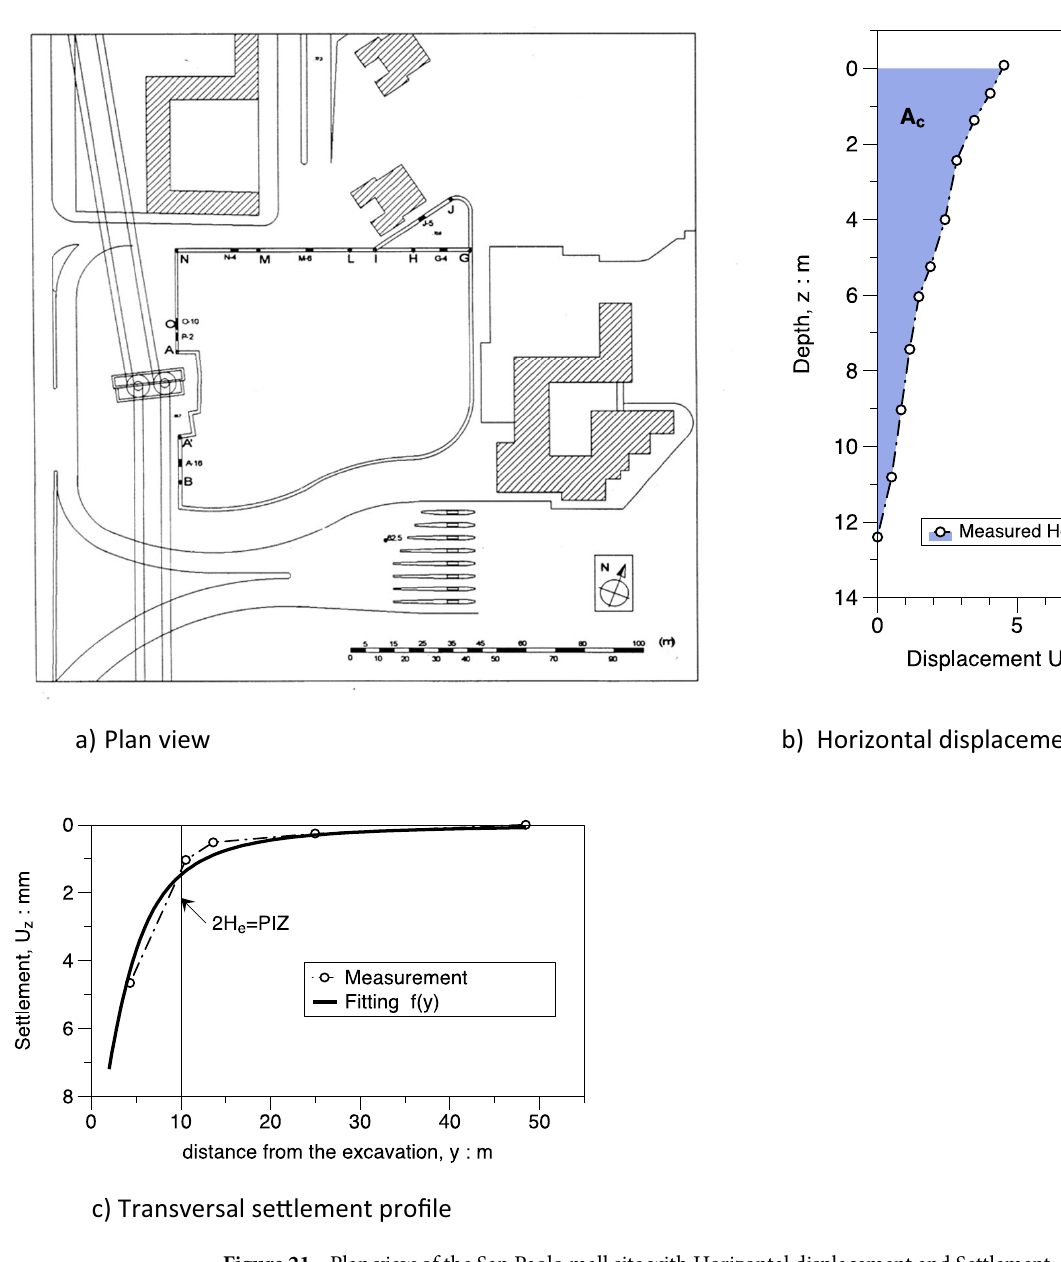
Figure 21. Plan view of the San Paolo mall site with Horizontal displacement and Settlement: comparison between predicted and measured behaviour (after Fenelli and Ramondini 40